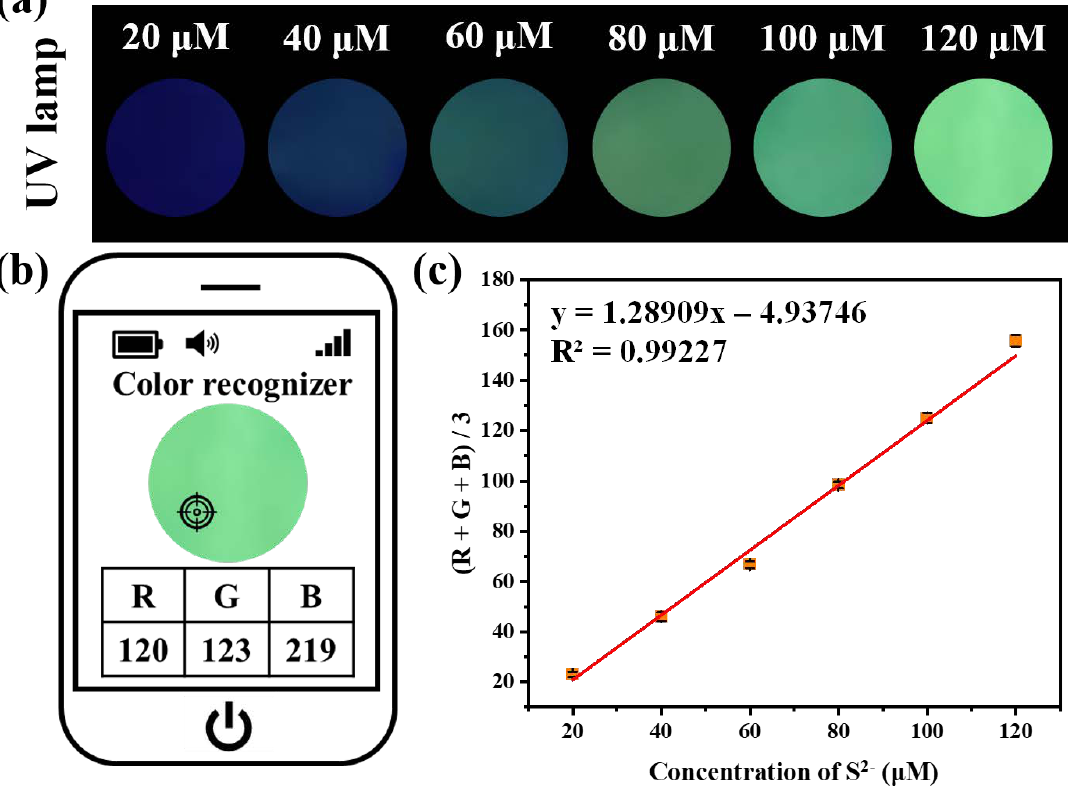
Figure 4. ( a ) Color changes of fluorescent test strips prepared by filter papers embedded with Cu[GluC] after treated with different concentrations of S 2 − aqueous solution under UV lamp (365 nm) irradiation; ( b ) The RGB values of fluorescent test strips were obtained through a smartphone app; ( c ) The linear relationship of (R+G+B)/3 values of fluorescent test strips relative to the concentrations of S 2 − ( n =